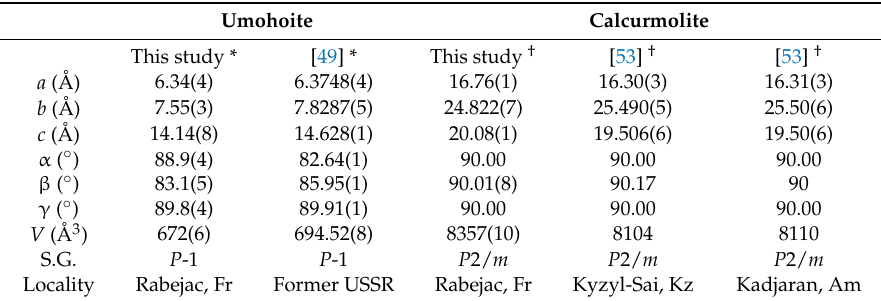
Table 13. Refined unit-cell parameters of umohoite and